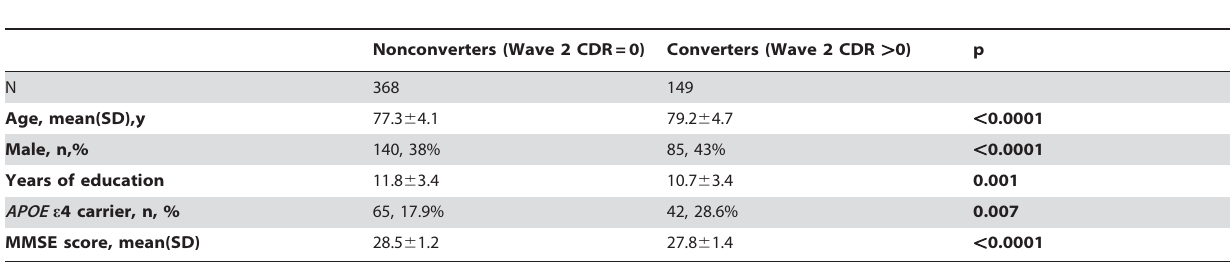
Table 6 . Demographic characteristics of nonconverters and converters at Wave